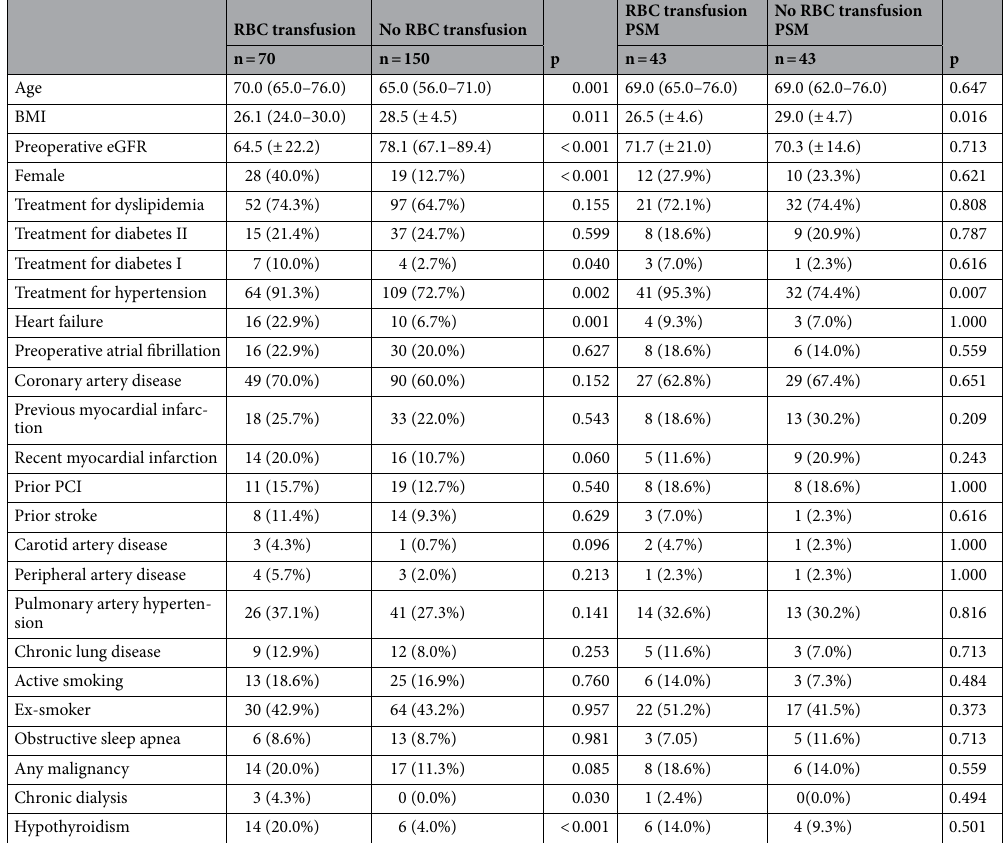
Table 1. Baseline characteristics of the study cohorts. Continuous variables are reported as median and interquartile range or mean and standard deviation. Categorical variables are reported as counts